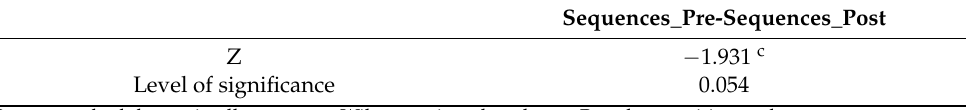
Table 9. Output of statistics of Wilcoxon signed-rank test for the sequence programming concept and Dual group.